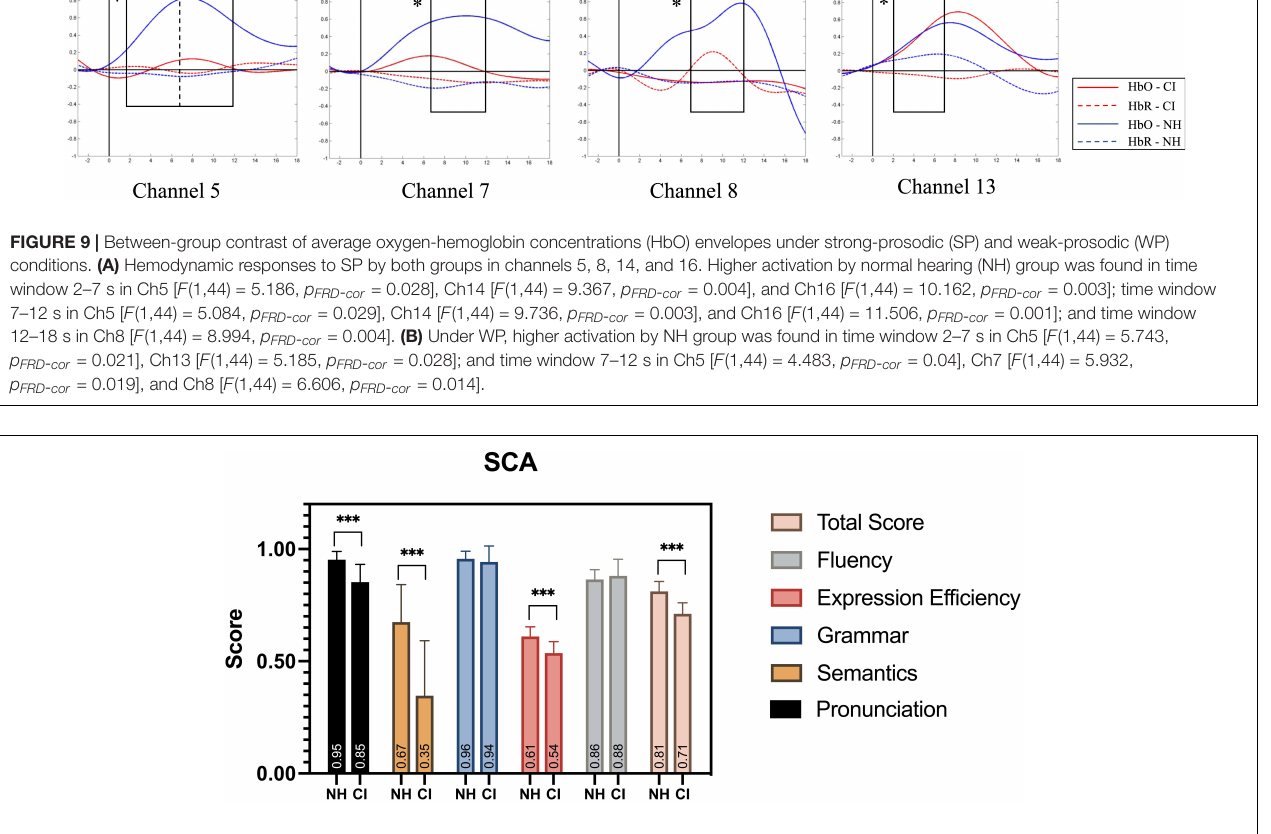
FIGURE 10 | SCA assessment results. Between groups, significant differences in scores were found in total score, pronunciation, semantics, and expression efficiency. *** p <